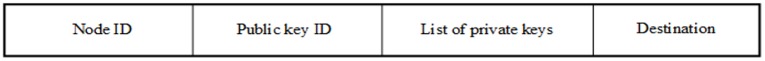
Structure of beacon Packet.